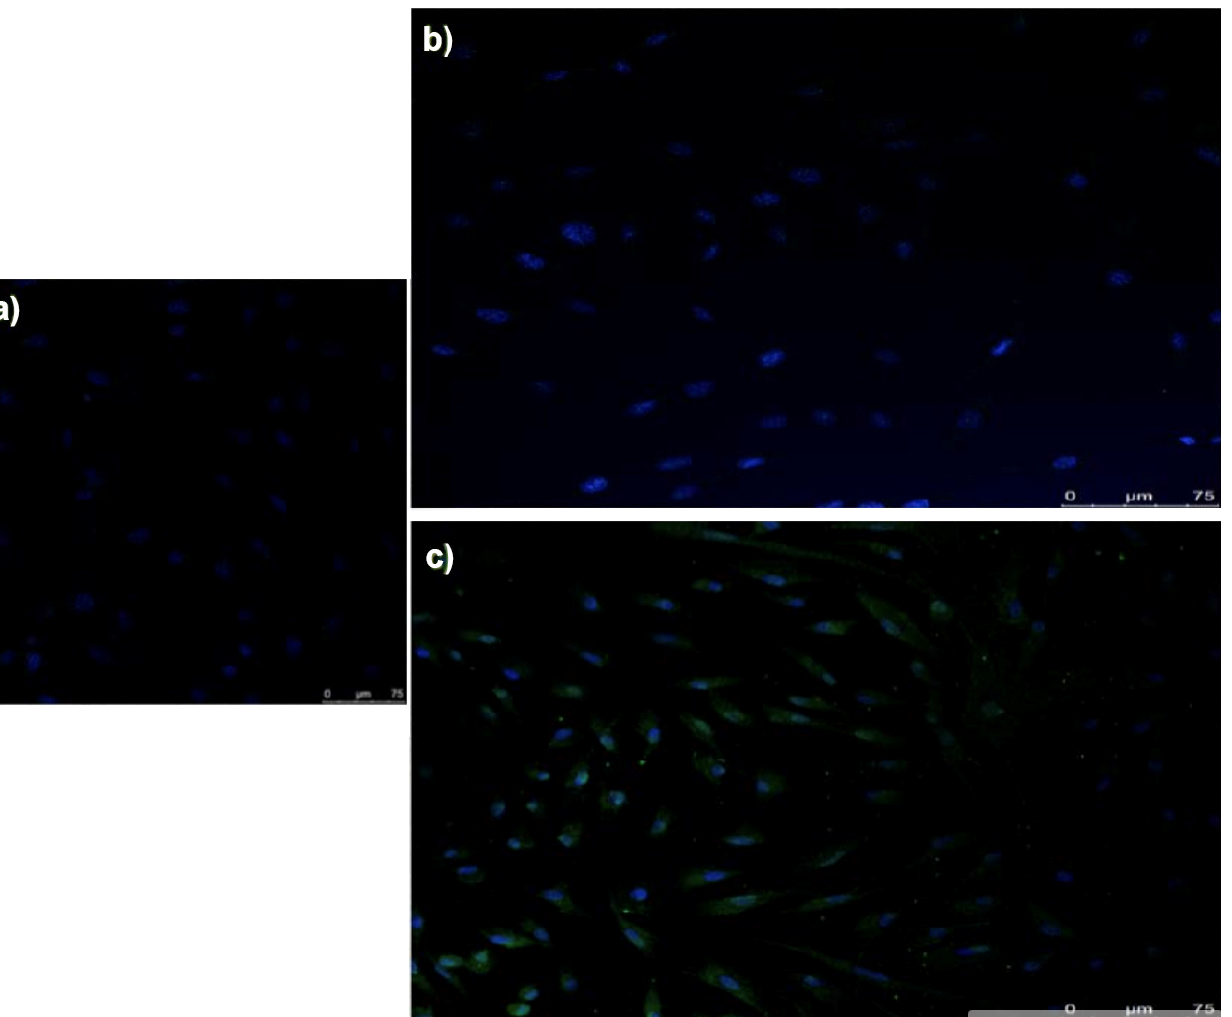
Figure 11. BMPR-II determination by immunofluorescence techniques: ( a ) negative control; ( b ) fibroblast cultures; and ( c ) MSCat cultures.